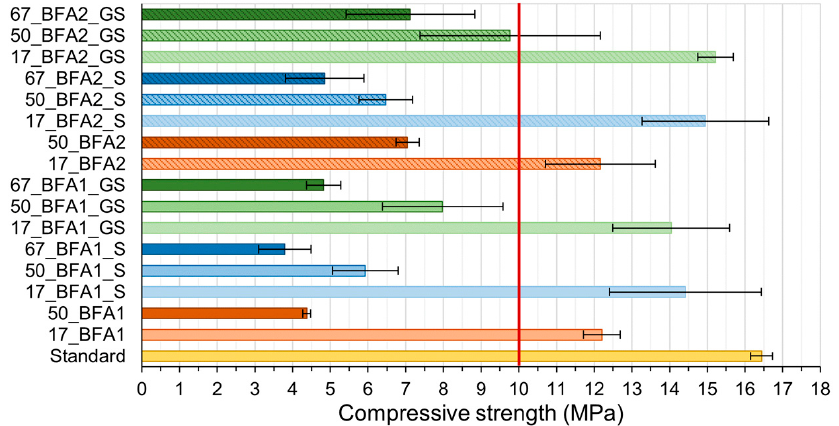
Figure 7. Compressive strength of the mortars cured for 28 days, compositions prepared with BFA1 and BFA2. The red line represents the minimum values required for the target application.